Question: Author a descriptive caption for the visualization shown.
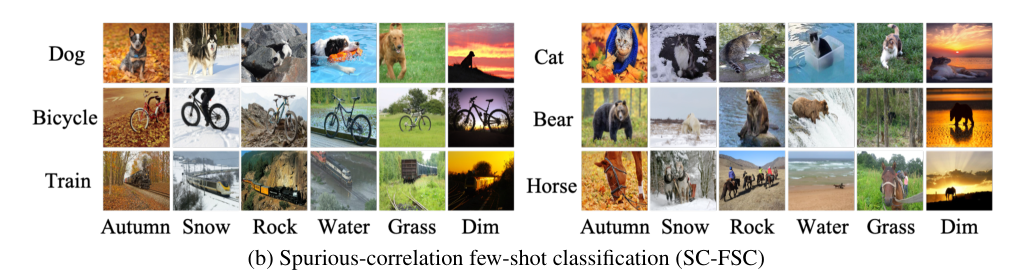
Answer: Example of cross-domain shifts and spurious-correlation shifts in FSC. (a) In Meta- dataset with cross-domain shifts (Triantafillou et al., 2020), the model is trained on base classes sampled from three datasets including miniImageNet, CUB-200-2011 and Aircraft, then tested on novel classes drawn from VGG Flower. (b) In our proposed MetaCoCo with spurious-correlation shifts, each class (or concept, e.g., dog) consists of different backgrounds (or context, e.g., autumn).